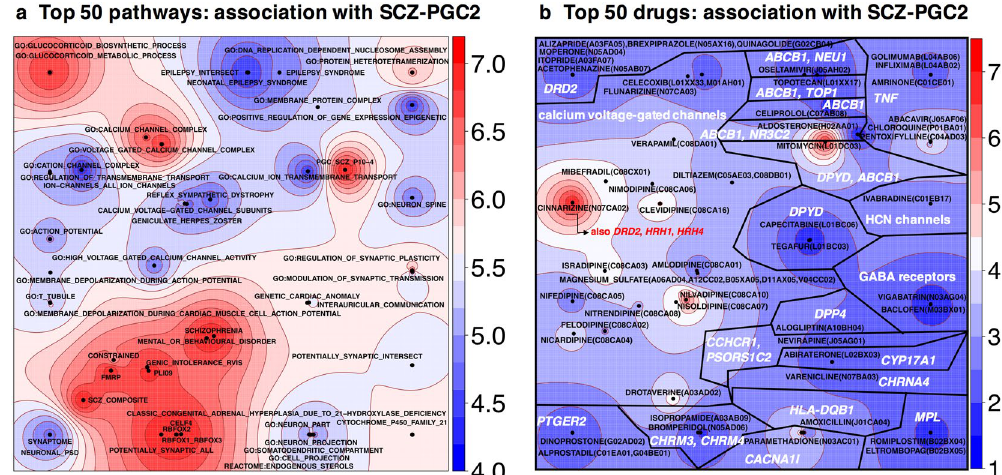
Figure 2. Pathway maps obtained using k-GTM (kernel Generative Topographic Mapping), a dimension reduction algorithm which projects pathways onto a 2D map. The points are gene-sets, positioned according to gene composition. The map is colored by − log 10 ( p ), which measures the degree of association of a gene-set with schizophrenia. ( a ) Top 50 pathways in schizophrenia SCZ-PGC2 GWAS: GO ontology, canonical pathways, gene families or disease gene-sets defined in the Open Targets Platform. All these pathways are FDR-significant according to Benjamini and Hochberg’s q-values, whereas only 28 are Bonferroni-significant. ( b ) Top 50 drugs with identified ATC codes, with target information mined from DGIdb and K i DB. Labels indicate the ATC code for each drug, such as N05 for psycholeptics, as well as the most significant gene(s) in each segment of the